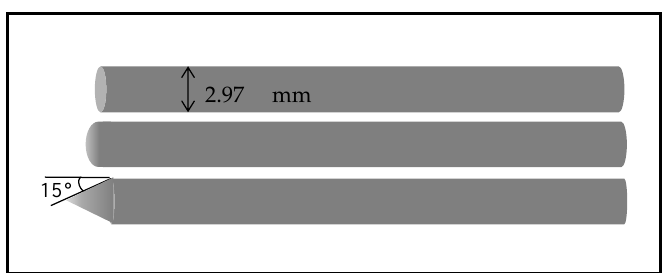
Figure 3. The nozzle geometry and the pressure measurement locations.